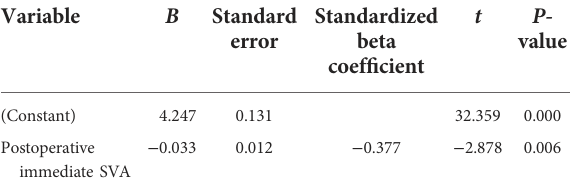
TABLE 4 Multiple stepwise linear regression analysis for the key clinically relevant parameter with total Scoliosis Research Society- 22 as the dependent